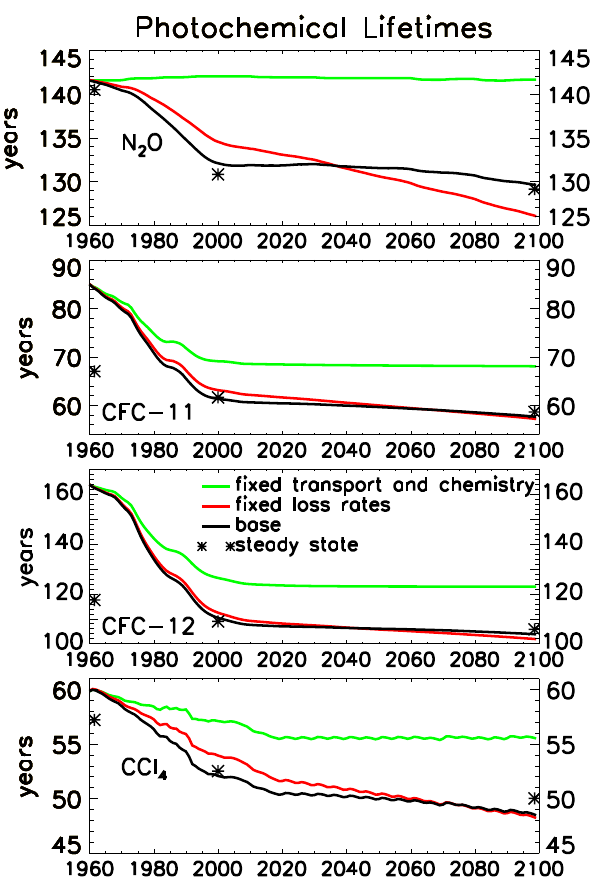
Fig. 13. Time series for 1960–2100 of the photochemical lifetimes for N 2 O, CFC-11 (CFCl 3 ), CFC-12 (CF 2 Cl 2 ), and CCl 4 from the base 2-D model simulation (black lines). The red lines are from the same base simulation except with the loss rates of N 2 O, CFC-11, CFC-12, and CCl 4 fixed at seasonally repeating 1960 values. The green lines are from a simulation using all chemistry and transport fixed at seasonally repeating 1960 values illustrating the effect of the changing atmospheric burden. The asterisks depict the steady state lifetimes for 1960, 2000, and 2100.